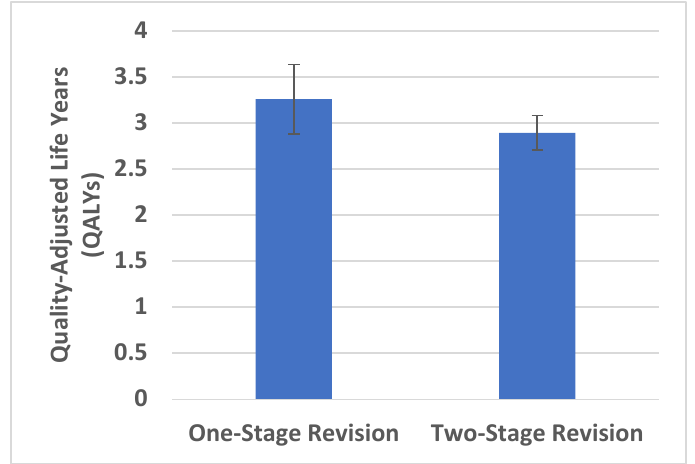
Figure 1. Cumulative quality-adjusted life years (QALYs) for each group. Error bars represent standard error of the mean.